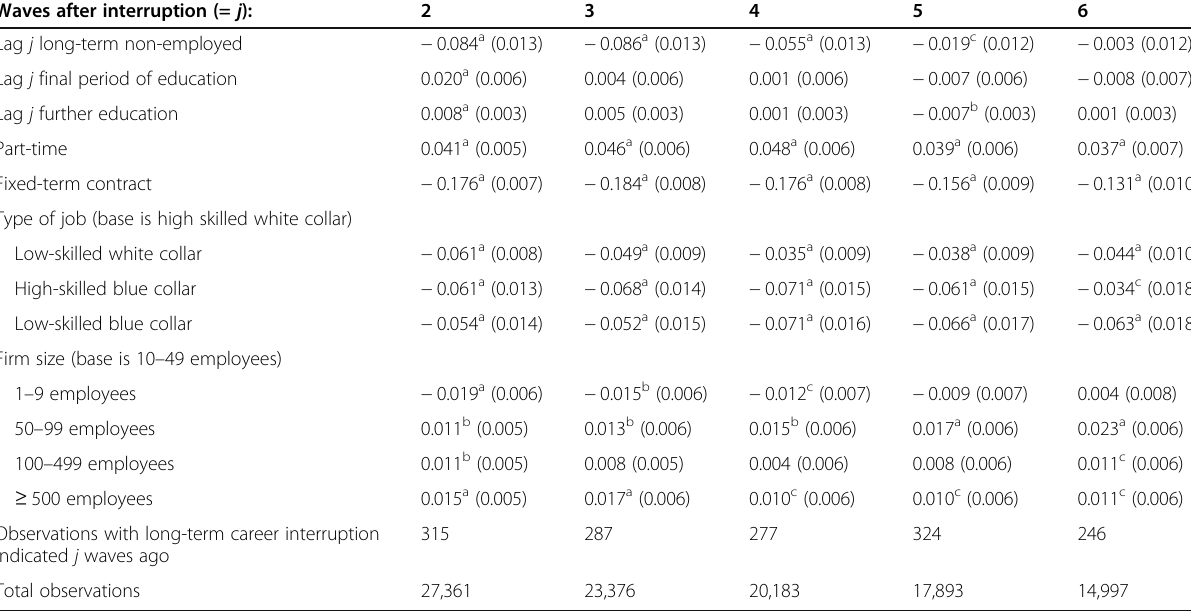
Table 3 Long-run estimates of log real hourly wage equations Waves after interruption (= j ): 2 3